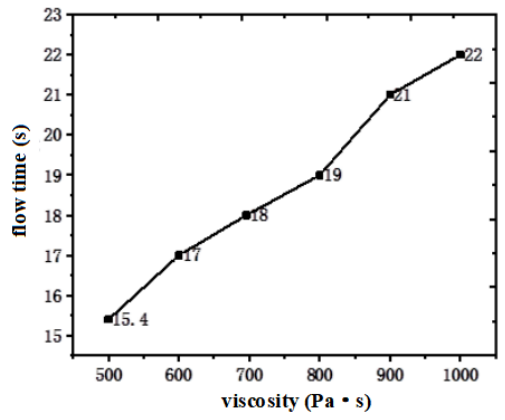
Figure 4. Relationship between flow time and viscosity of hot-melt glass on SiO 2 substrate.